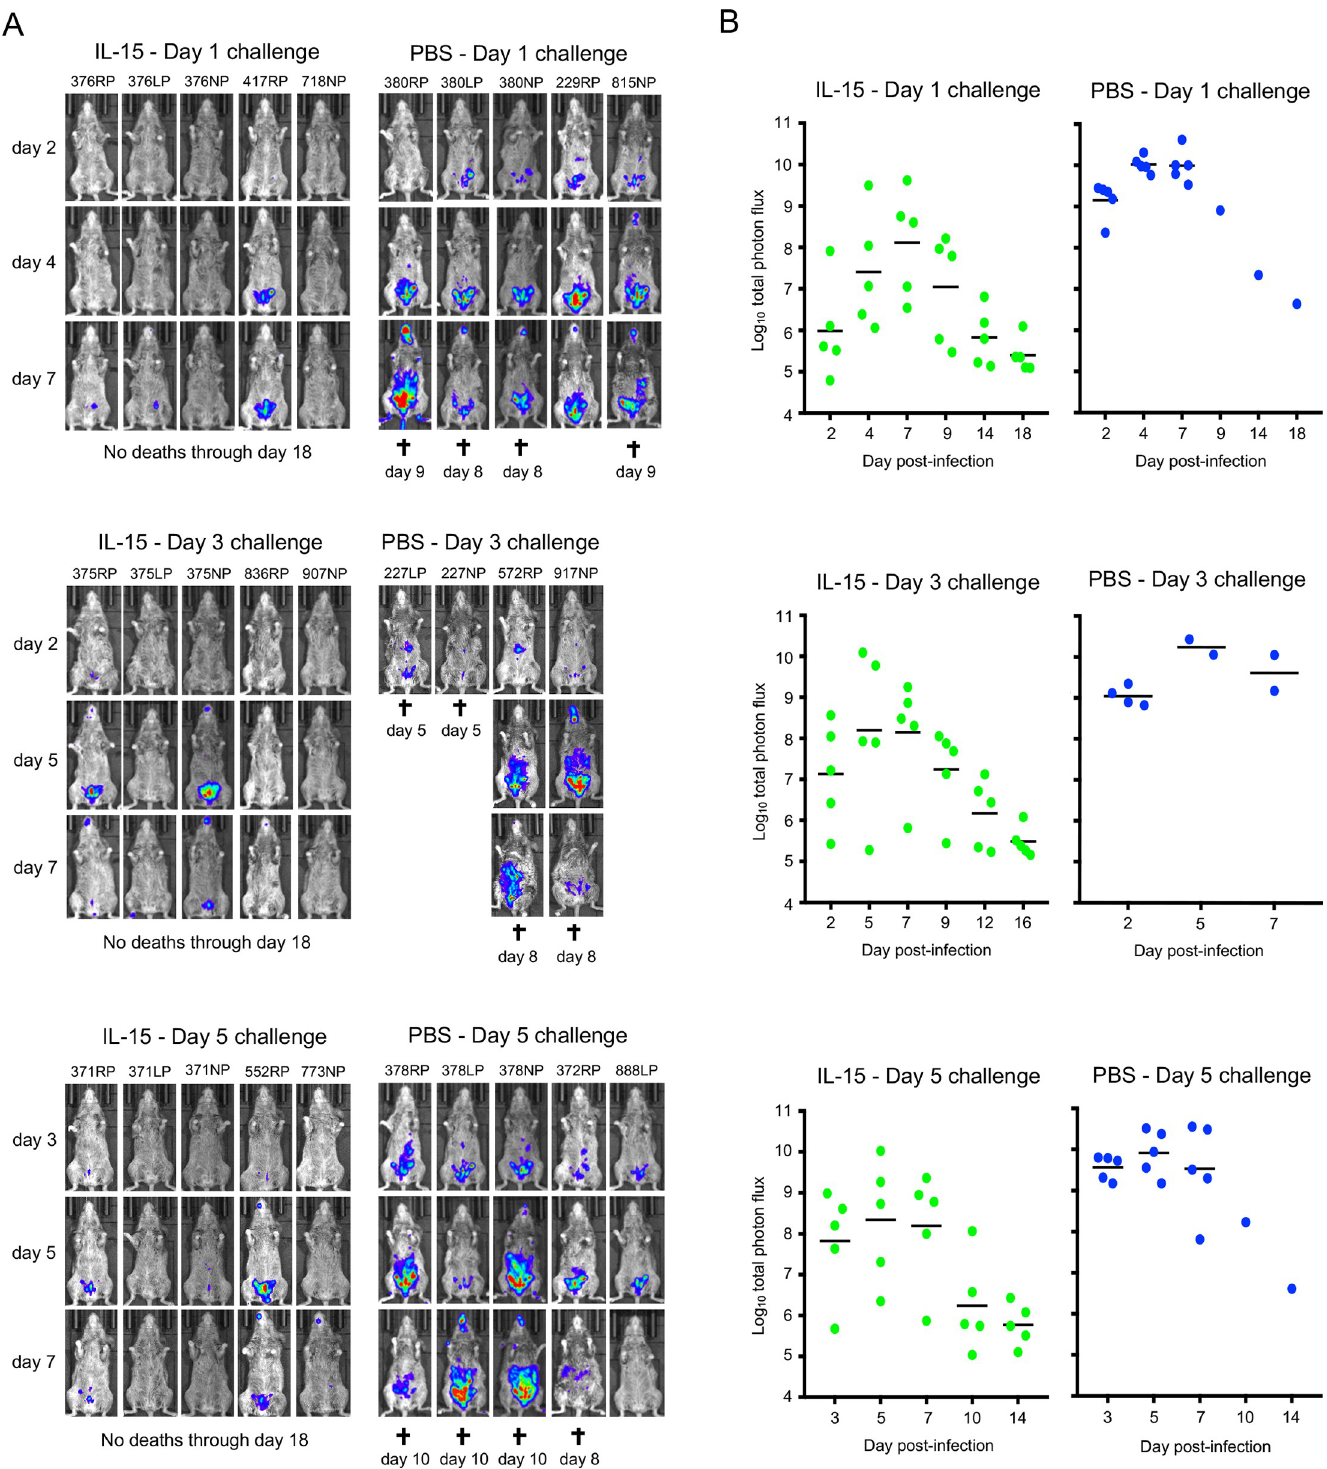
Fig 2. VACV challenge of IL-15-treated CAST mice. (A) CAST mice were treated with IL-15 or PBS as in Fig 1 and challenged IP with 460 PFU of VACV expressing FLuc on days 1, 3 and 5 after cessation of IL-15 administration. The progress of infection was measured by injecting luciferin and measuring luminescence. Ventral view images of surviving mice are shown on the indicated day post-infection using the same exposure time and binning factor, which was insufficient to show the low levels of luminescence seen at higher exposure in some mice. Red, blue and purple denote intensity of luminescence from high to low. Days of death or euthanasia (†)